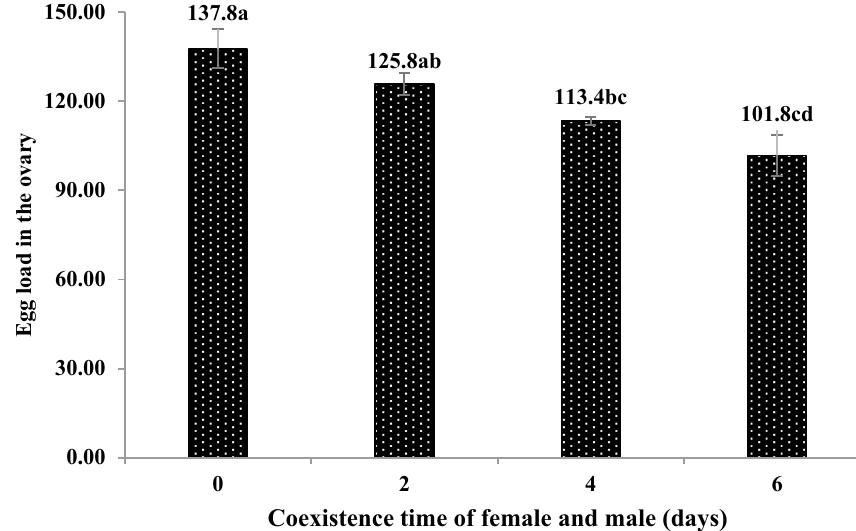
Figure 5. The egg load in the ovary of C. japonicus at different coexisting time of female and male adults. Data in the figure is mean ± standard error, different letters indicate significant differences in Duncan’s test, with a probability of 5%.